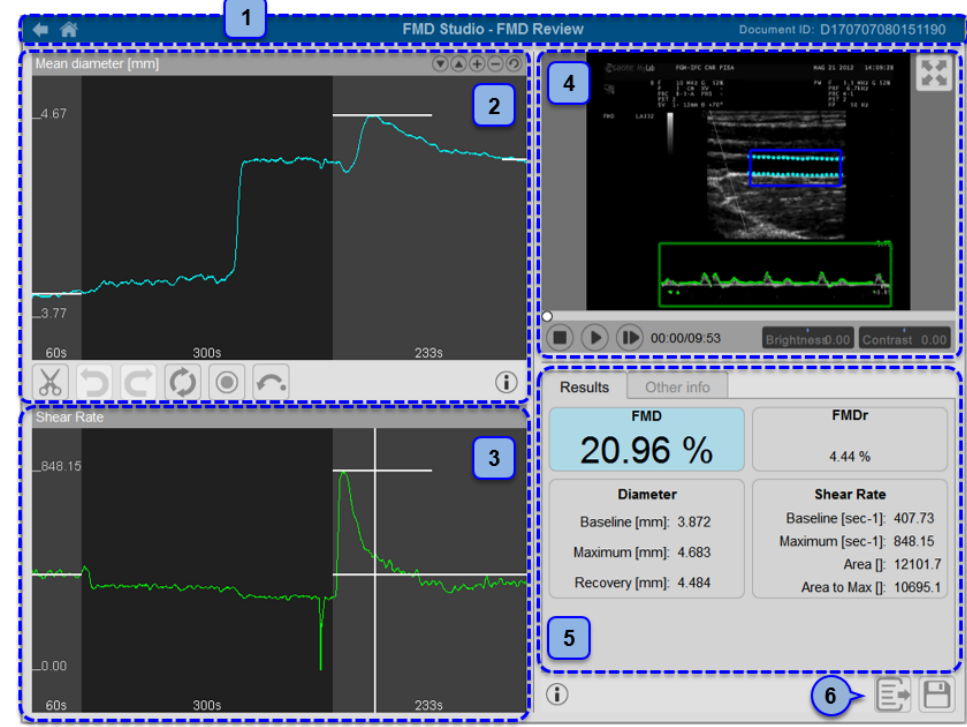
Figure 2. Automatic measurement of flow-mediated dilation (FMD) using a Food and Drug Admin- istration (FDA)-cleared software. 1: Document identifier; 2: mean diameter; 3: shear rate; 4: video window; 5: results and info panel; 6: data exportation. Reproduced with permission from Quipu SRL, Pisa,